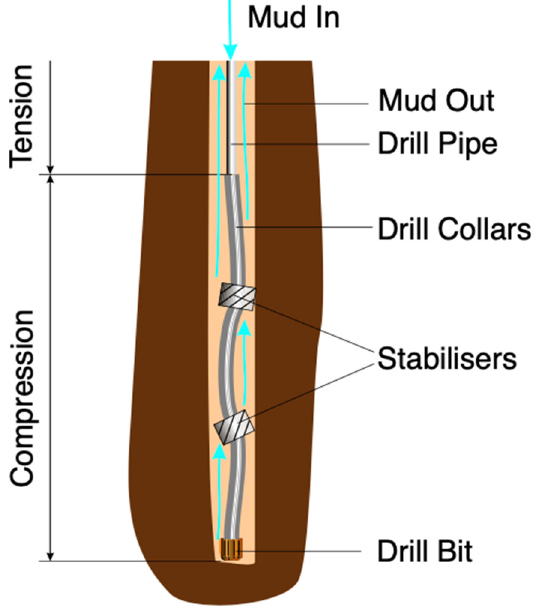
Figure 2. Buckling of the BHA.